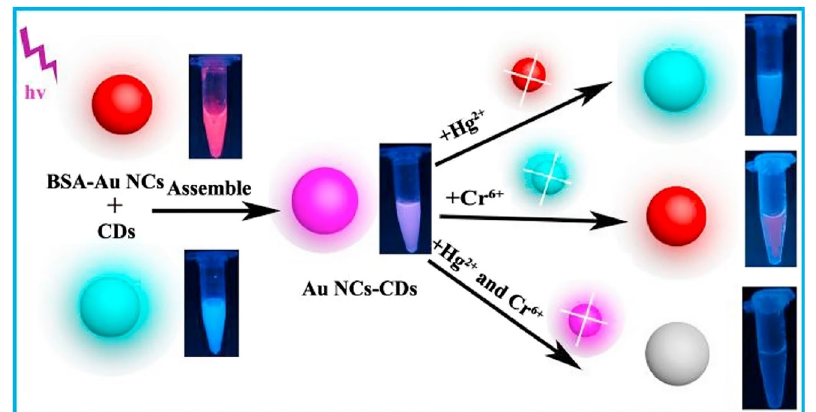
Figure 3: The schematic illustration of the preparation of gold nanoclusters (Au NCs)- carbon dots (CDs) and detection for metal ions of Hg(II) and Cr(VI). Reprinted from Su et al. ’ s work with the kind permission of Elsevier [107]. Copyright (2018)